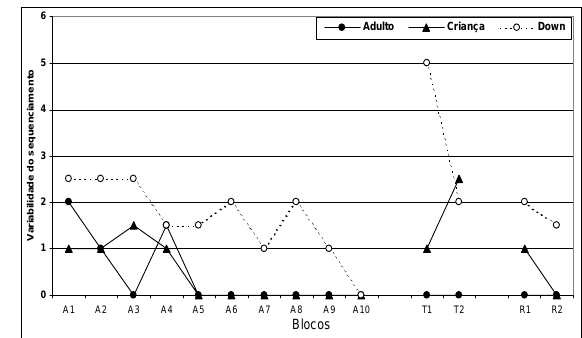
Figura 4. Mediana da variabilidade do timing relativo ao longo das fases para os três grupos.